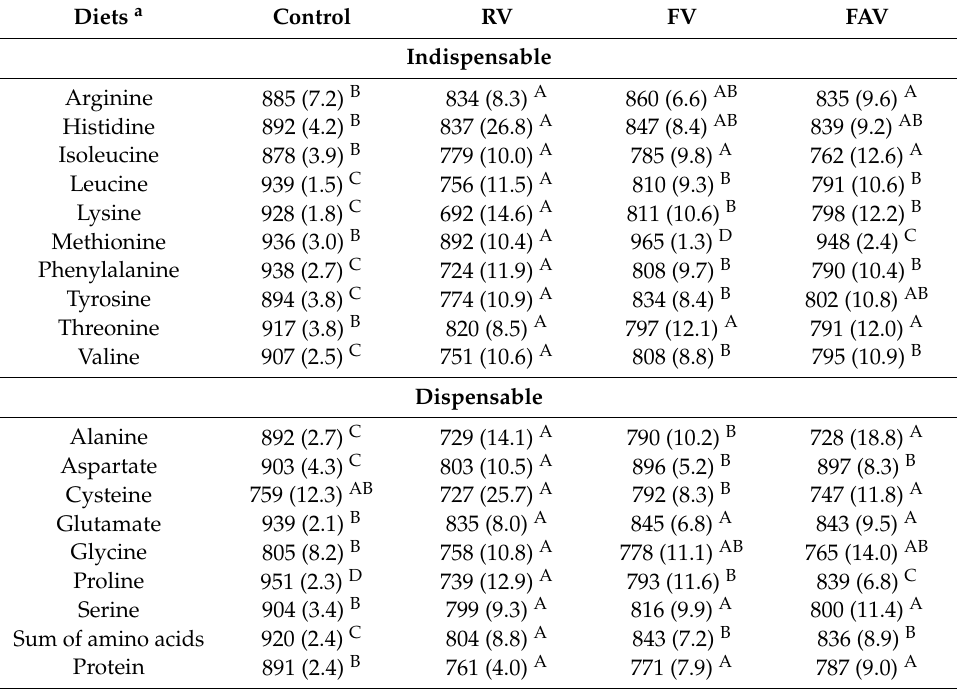
Table 4. Apparent fecal digestibility, g · kg − 1 of amino acids in rats ( n = 10) fed diets based on casein or cowpea as the only protein